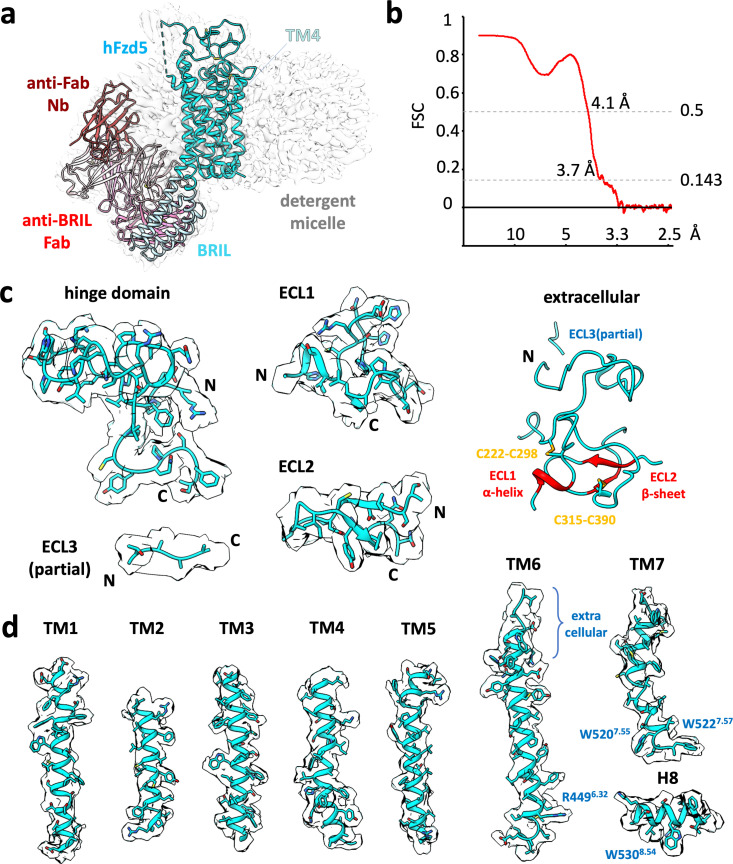
Cryo-EM map of representative built in model.(a) Cryo-EM map (gray) and structural model of hFzd5ICL3BRIL in detergent complexed with anti-BRIL Fab and anti-Fab Nb. The model is colored as follow: the sequences from Fzd5 (cyan), BRIL and the linker between BRIL and Fzd5 (light blue), Fab heavy chain (pink), Fab light chain (light pink) and Nb (brown). (b) The map-model FCS curve generated by Phenix refinement (masked). Cryo-EM volumes (pale cyan) around the (c) extracellular regions and (d) individual transmembrane helices of hFzd5. Except for the whole extracellular region (c right) which only shows disulfide cysteine resides with red colored secondary structures assigned by DSSP, all sidechains are displayed regardless of their quality or model placement.